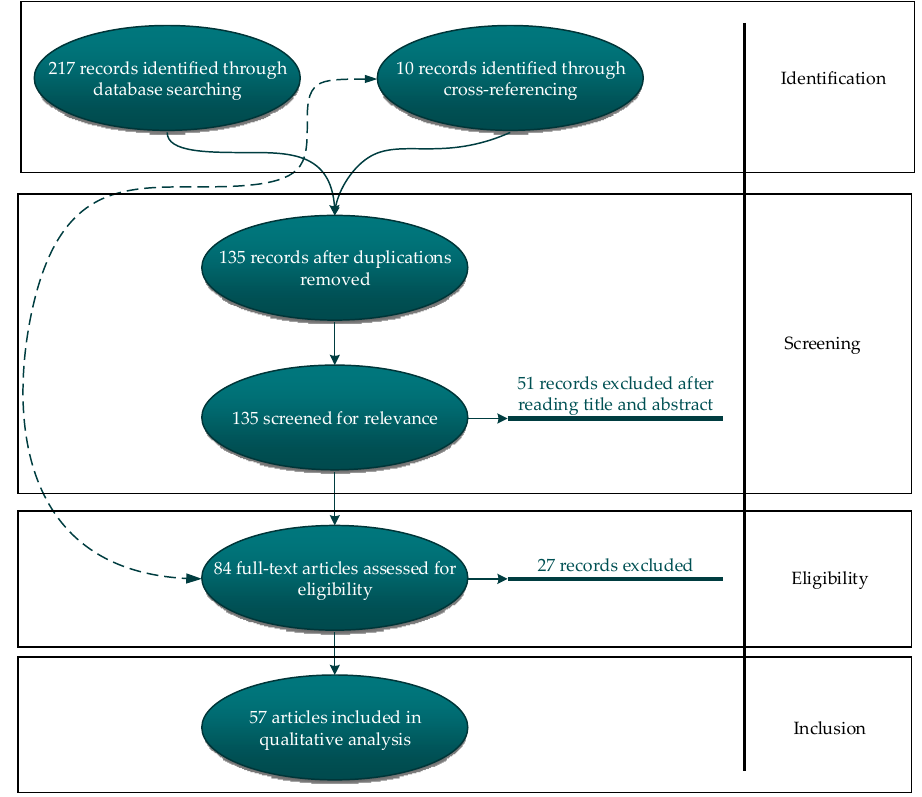
Figure 2. Diagram of the systematic selection, evaluation, and quality control of the database using the Prisma model.